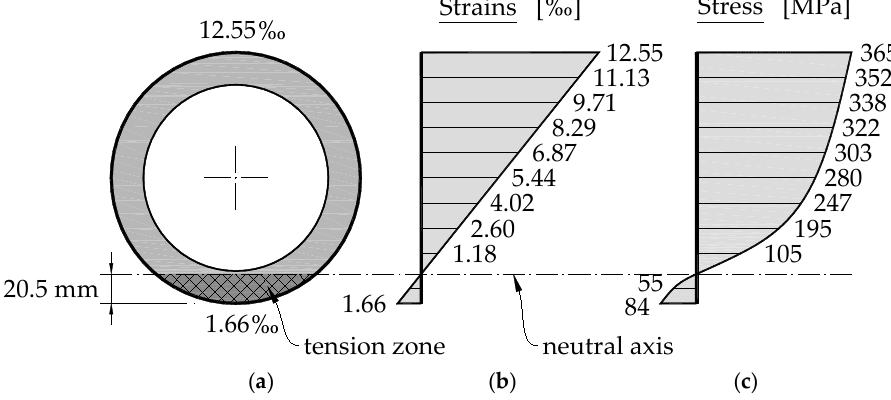
Figure 11. Strains and corresponding stress in the column cross-section: ( a ) location of the neutral axis, ( b ) strain distribution, ( c ) stress distribution.